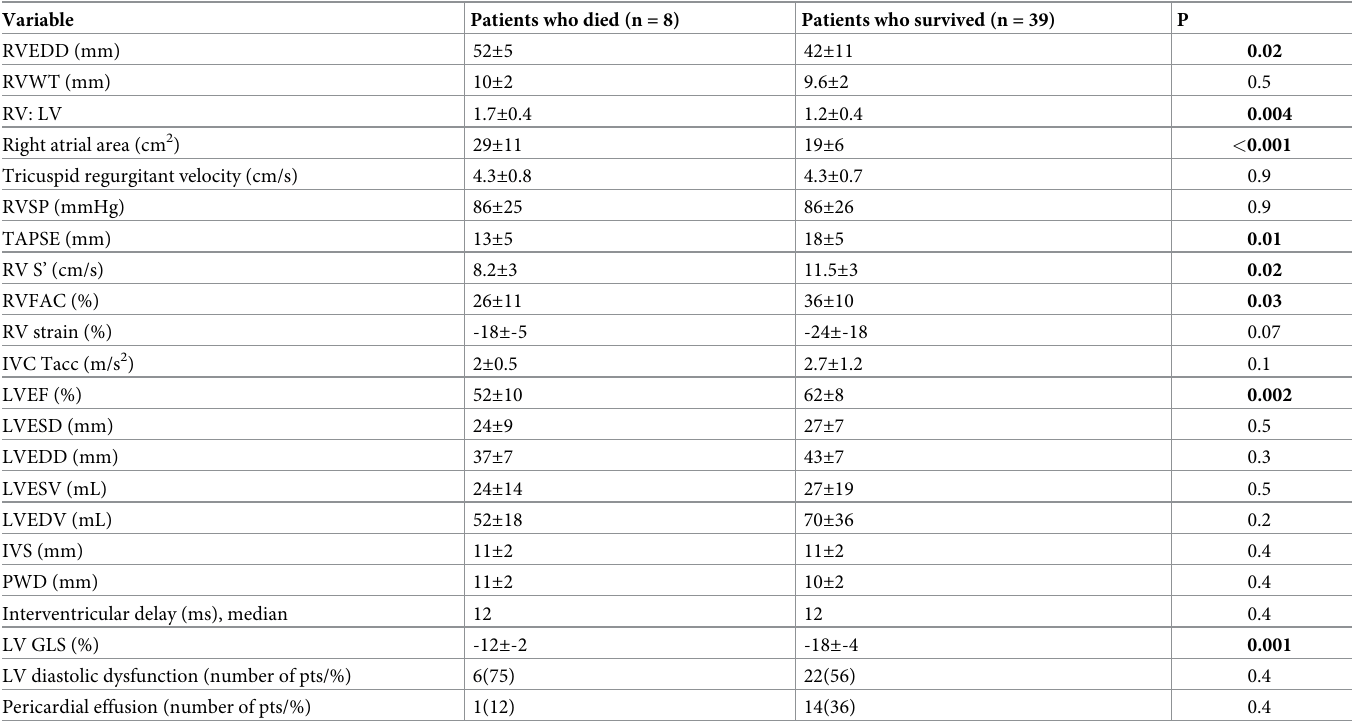
Table 3. Baseline echocardiographic characteristic of patients in the two study